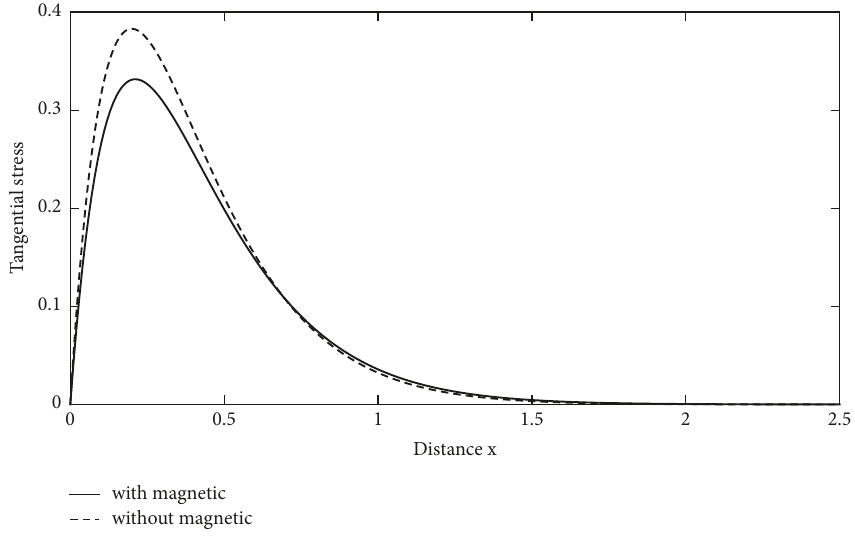
Figure 12: Effect of magnetic field on tangential stress distribution.